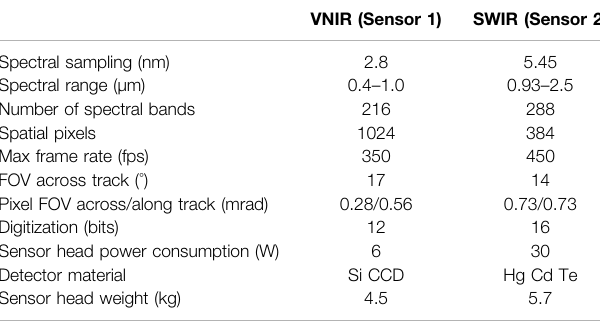
TABLE 2 | HySpex spectrometer